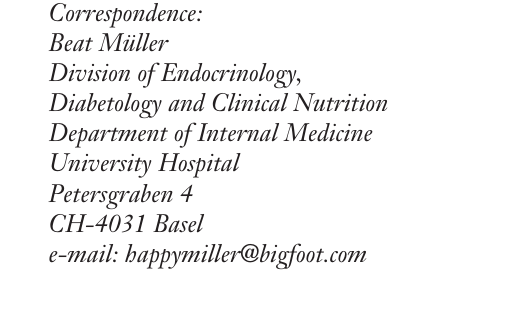
25 clinical indica- tions, guidelines and caveats for the inter- pretation of serum